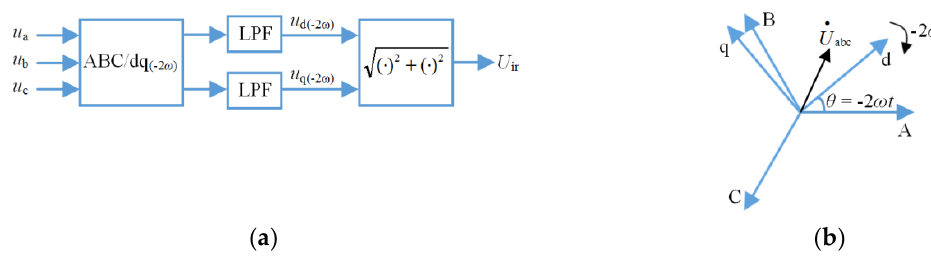
Figure 4. Negative sequence second harmonic voltages signal extraction. ( a ) Signal flow; ( b ) ABC to dq (−2 ω ) reference frame transformation.